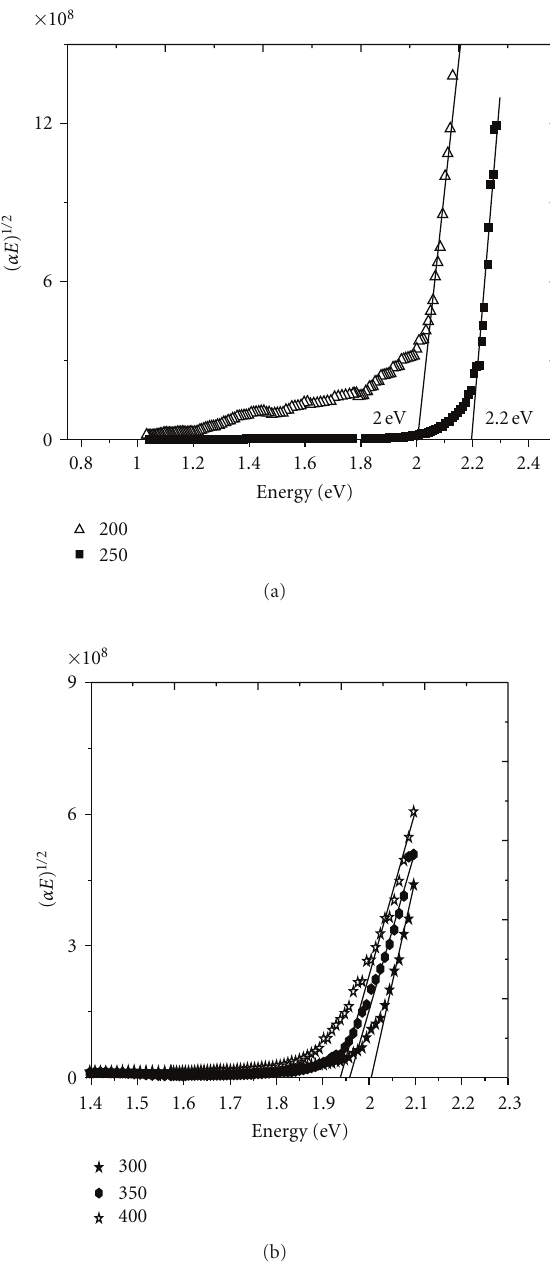
Figure 7: ( αE ) 1 / 2 versus energy E near the bandgap for the PASL